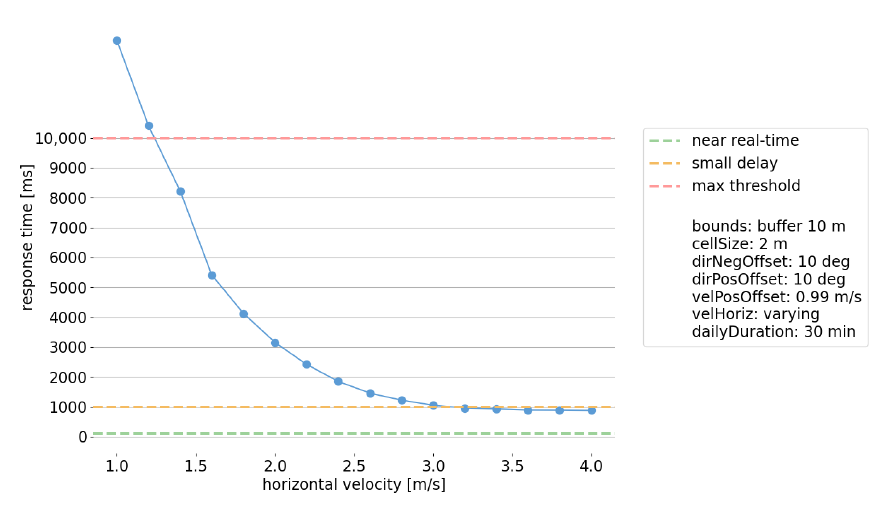
Figure 19. The response times when the horizontal velocity high-pass filter